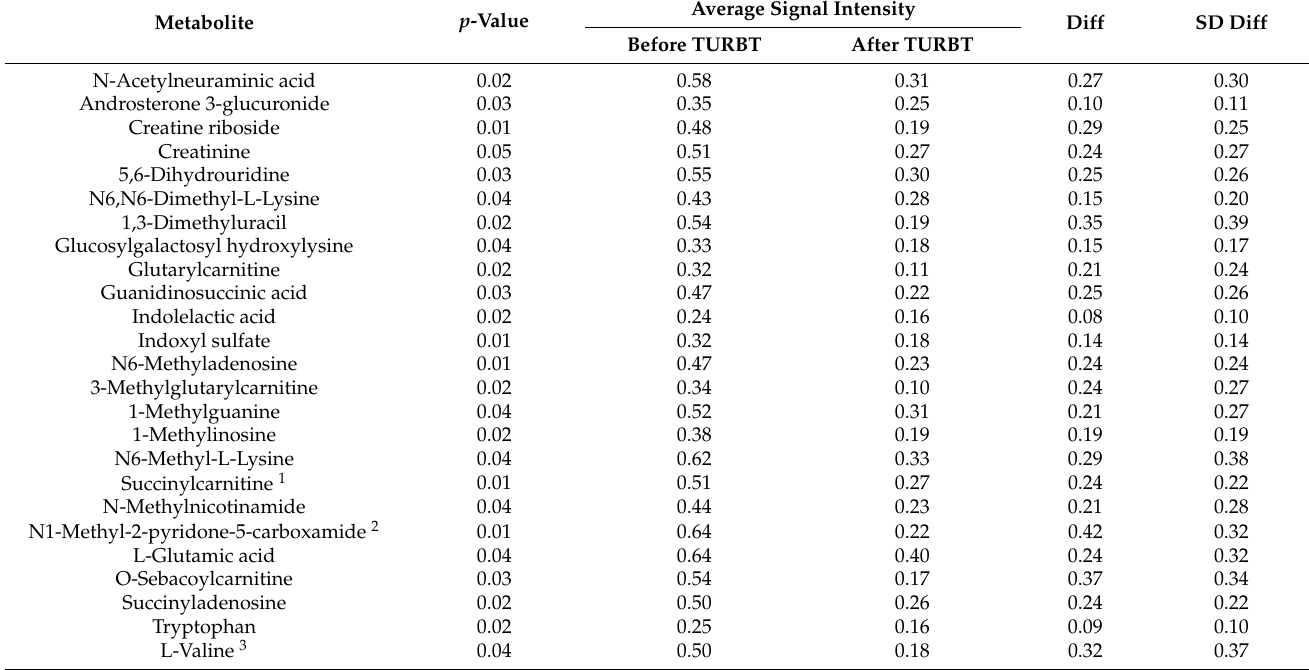
Table 2. A summary of the significance of differences in annotated metabolite levels (before TURBT (point 1) vs. after TURBT (point 3)). Signal intensities were normalized by SG and scaled. p